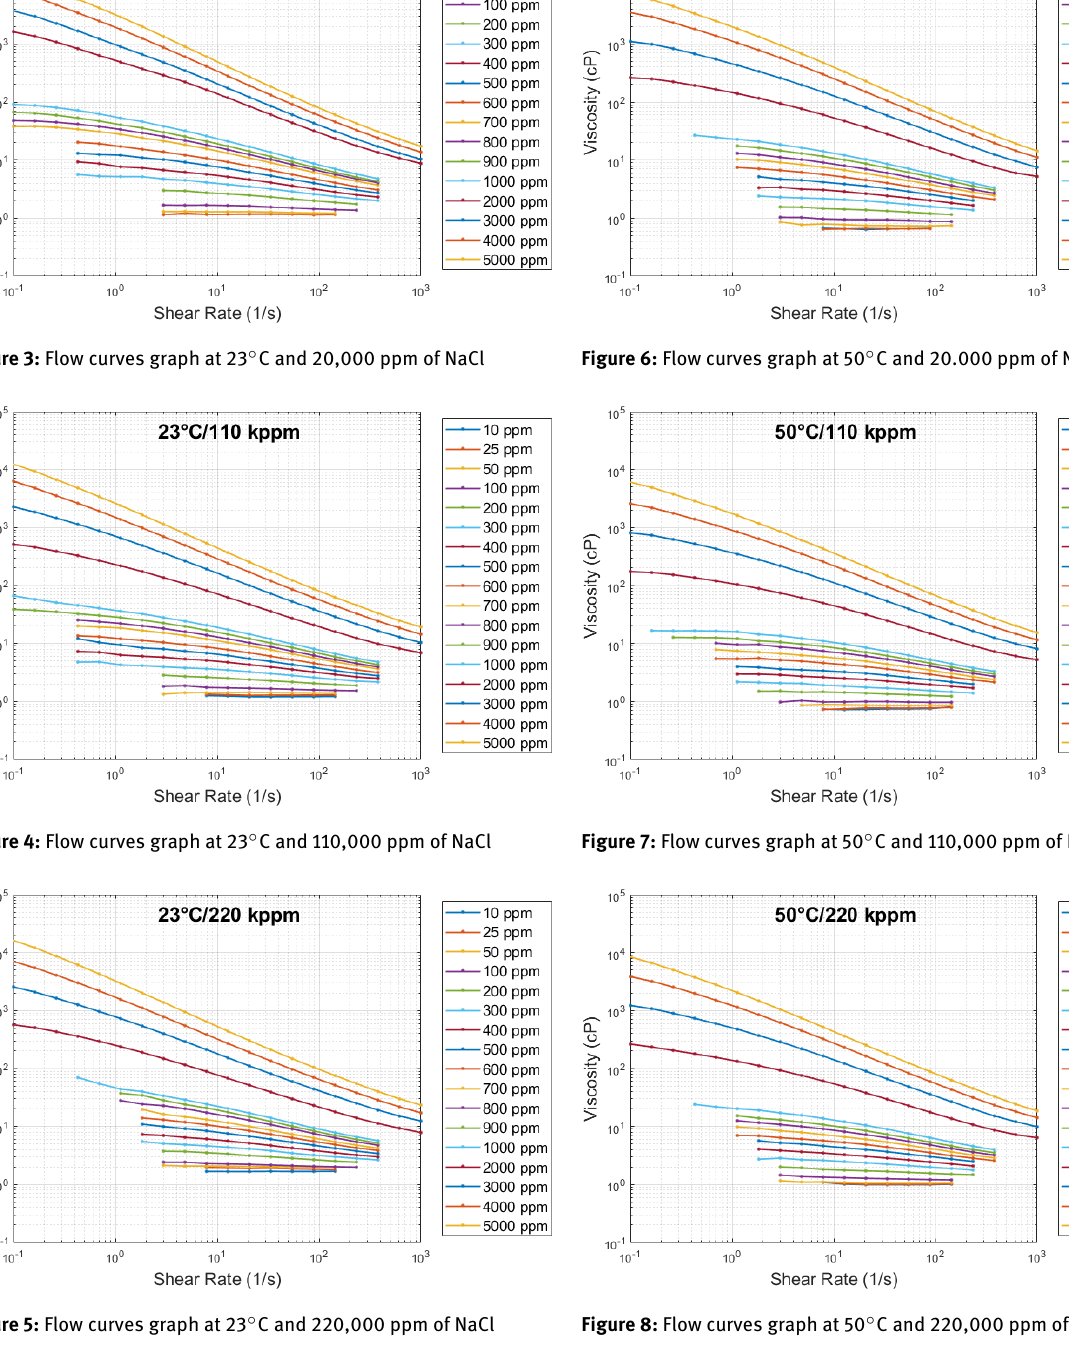
The flow curves were recorded at shear rates between (10 −1 and 10 3 ) s −1 with 20 measurement points. The acqui- sition mode was controlled by the shear rate.